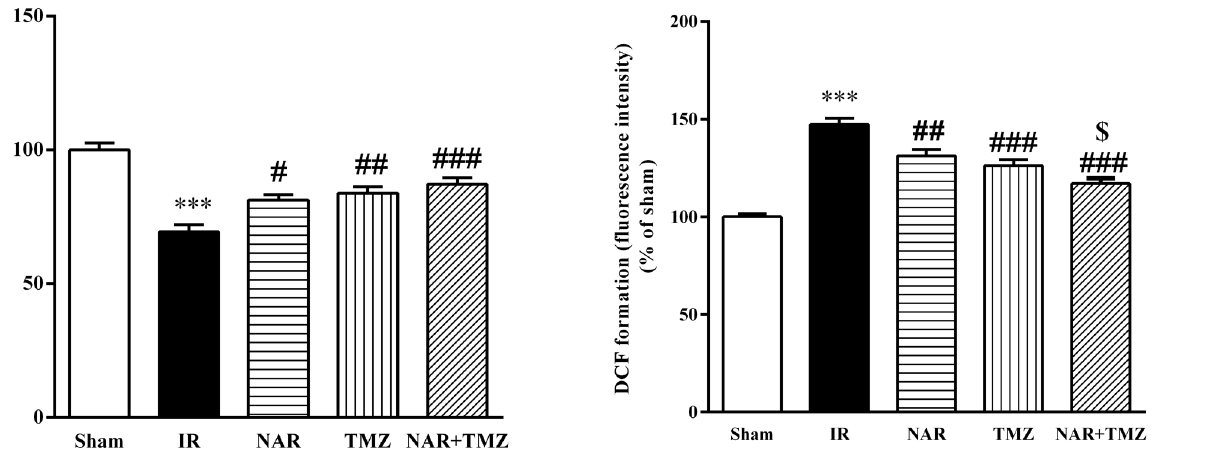
FIGURE 3 - Effect of Naringin (NAR) and Trimetazidine (TMZ) or their combination pretreatment on mitochondrial ROS following renal IR injury (mean ± SEM n=8). Sham (sham operated group), IR (Ischemia-reperfusion + normal saline), NAR (Ischemia-reperfusion + 100 mg/ kg, intraperitoneally, for one week), TMZ (Ischemia + 5 mg/kg TMZ, intravenously, before reperfusion) and their combination (NAR + TMZ). One-way ANOVA followed by Tukey’s post hoc test. ***p< 0.001 vs. sham group; ## p< 0.01; ###p< 0.001 vs. IR group; $ p< 0.05 vs. NAR